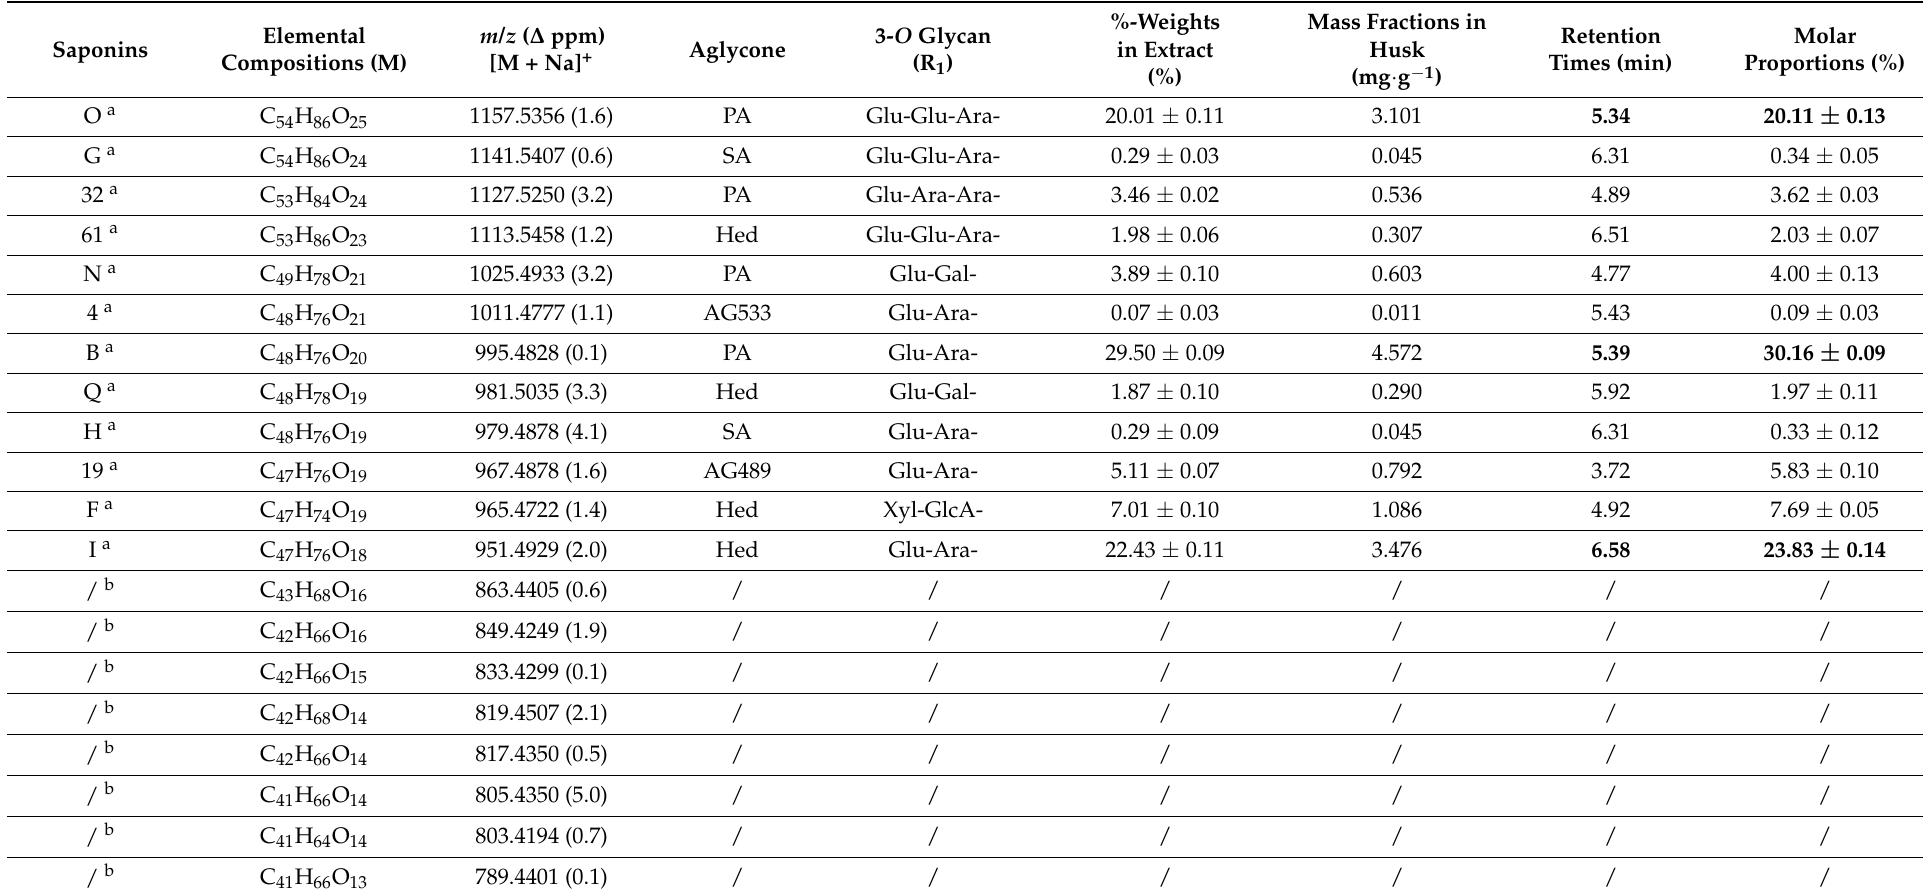
Table 1. Chenopodium quinoa husk extract: data collected by MS-based experiments. The compositions and mass error measurements ( ∆ ) were determined by MALDI-HRMS. a The saponins were identified based on liquid chromatography (LC-MS) and collision-induced dissociation experiments (LC-MSMS). b The saponin ions detected between m / z 789 and 863 are [2 + 0] fragment ions generated during the MALDI ionization from the [2 + 1] saponins. The %-weights in extracts and the mass fractions (mg · g − 1 of Chenopodium quinoa husk powder) were determined based on the LC ion signal intensity ratios, with Hederacoside C as an internal standard, and using the gravimetric extraction yield (15.5 mg · g − 1 ). The molar proportions (%) were determined based on LC ion signal relative integration. See the “Materials and Methods” section for the details of all the quantitative